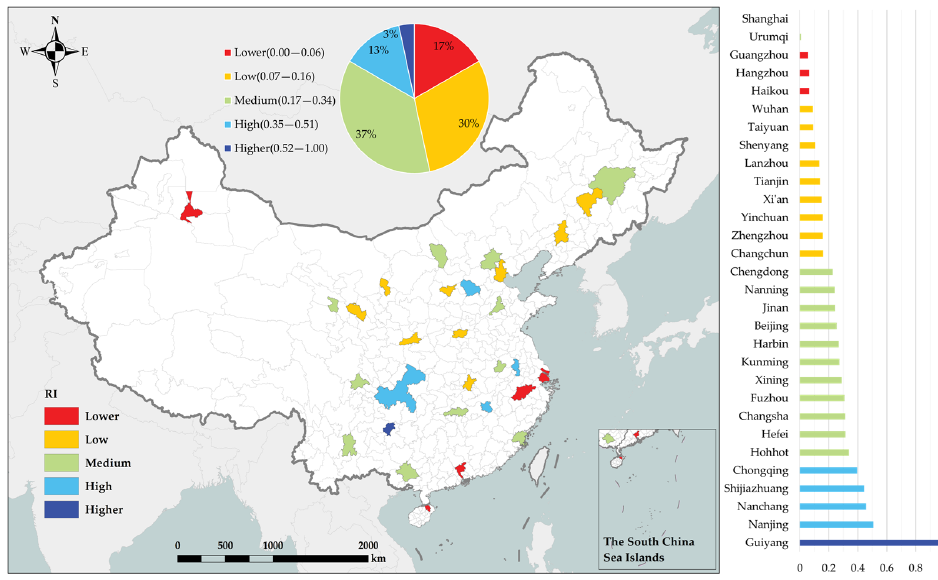
Figure 9. Response index map.